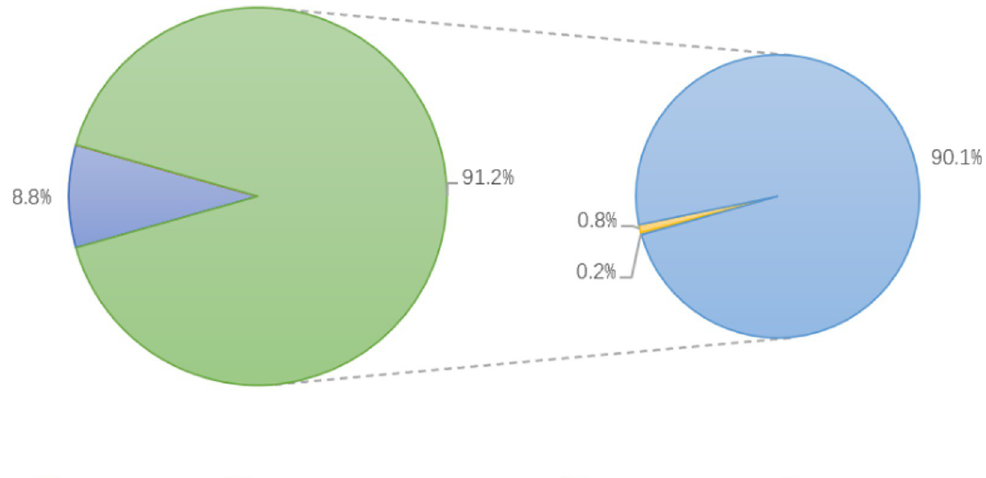
Fig 2. The distribution of bacterial samples from different areas.